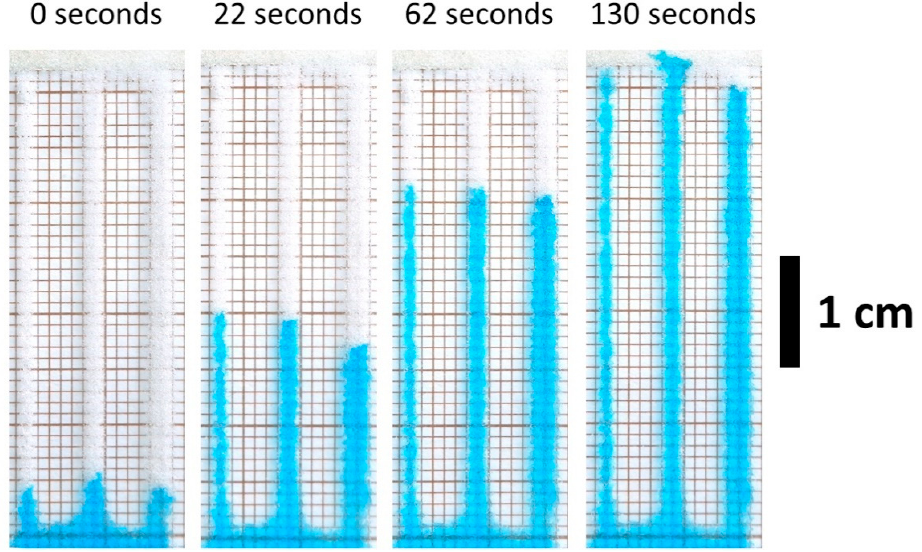
Figure 6. Example of wetting time measurement with print ( R5 ) from Figure 5, printed with DWP.